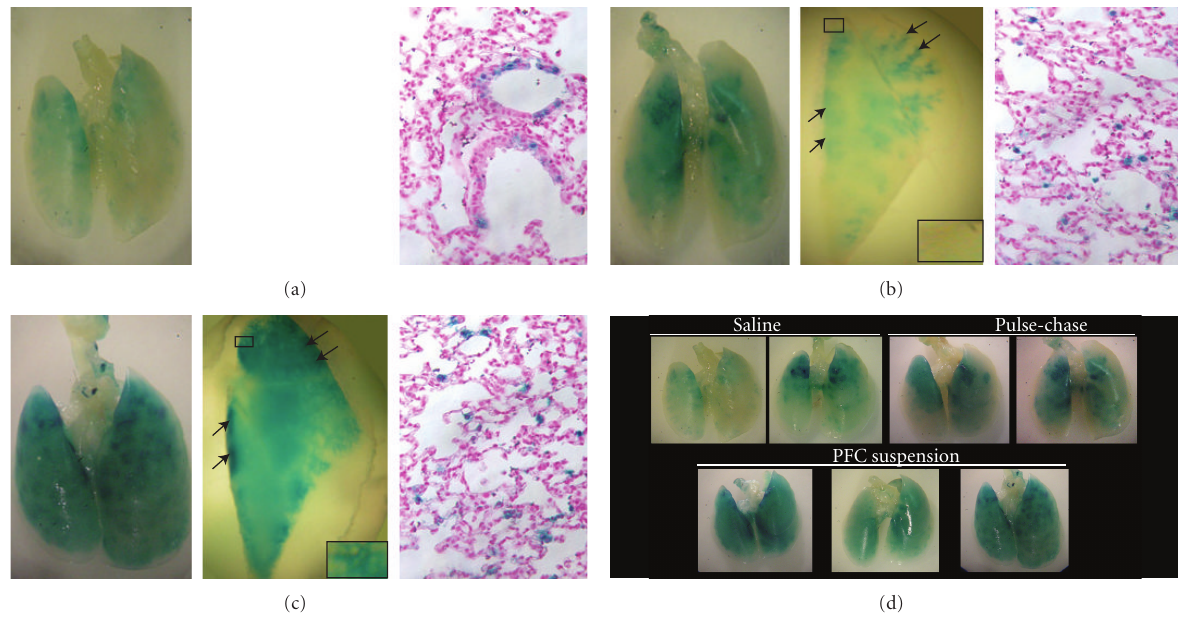
Figure 2: PP2/PP9 suspensions improve transgene expression in the distal lung. Left Panel: whole mounts of lungs from mice transduced with rAd-CMVLacZ (2 . 7 × 10 10 viral particles) administered intratracheally in (a) saline alone, (b) saline followed by a chase of PP2:PP9 (10mL/kg), or (c) rAd/PP2:PP9 suspension. (a) Proximal airway expression is seen predominantly when rAd is delivered in saline alone. (b) Increased expression in proximal and distal lung is seen when delivery of the virus in saline is followed by a PP2:PP9 chase; (c) Greatest staining compared to the other methodologies in the alveolar spaces and the distal lung with delivery of rAd in PP2:PP9 suspensions. Middle Panel: lungs were removed, embedded in para ffi n, and sectioned to the same approximate depth. Inset in middle panel C demonstrates a distinctly alveolar pattern in the PFC liquid/rAd lungs and a lack of staining in the corresponding region of the virus in saline is followed by a PP2:PP9 chase (inset, middle panel (b)). Right Panel: sections were mounted on slides and counterstained with eosin.. When rAd is delivered in saline (right panel (a)), the signal was predominantly detected in the central airways with very little β -gal expression seen in the lung parenchyma. With virus delivered in saline followed by a PP2:PP9 chase (right panel (b)), there is an increase in the intensity of staining in the corresponding regions of the airways with more evidence of peripheralization With virus delivered as PFC suspension (right panel (c)), β -gal expression is seen in more global regions of the parenchyma. Based on the location and morphology, these cells appear to be type II cells. Panel D displays additional examples of whole mounts of lungs from mice transduced with rAd-CMVLacZ (2 . 7 × 10 10 viral particles) administered in saline alone, by saline followed by a chase of PP2:PP9 (10mL/kg), or as a rAd/PP2:PP9 suspension.